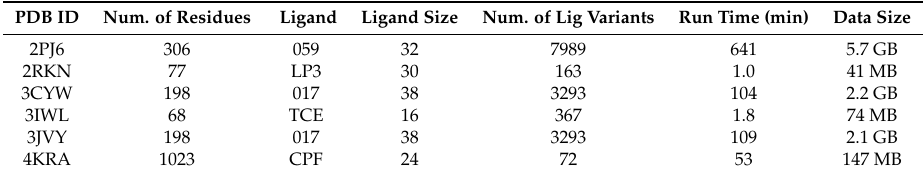
Table 2. Run-time and data metrics for a representative sample of the protein-ligand complexes we analyzed. These were run on a 6-core 3.7 GHz processor with 16 GB in a docker container, with 6 ligand variants generated then analyzed